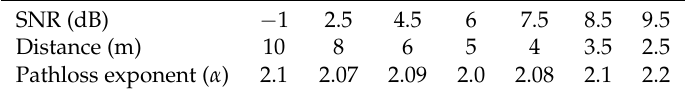
Table 5. Pathloss exponent calculation based on SNR measurements.